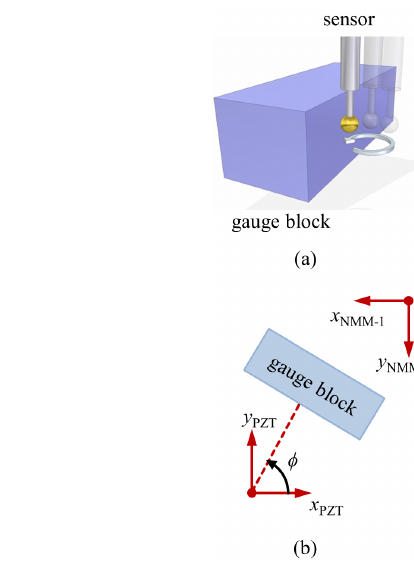
Figure 13. (a) Arrangement of the measurement system; (b) top view with the coordinate system of the piezo actuator, φ : to be determined angle; (c) measurement